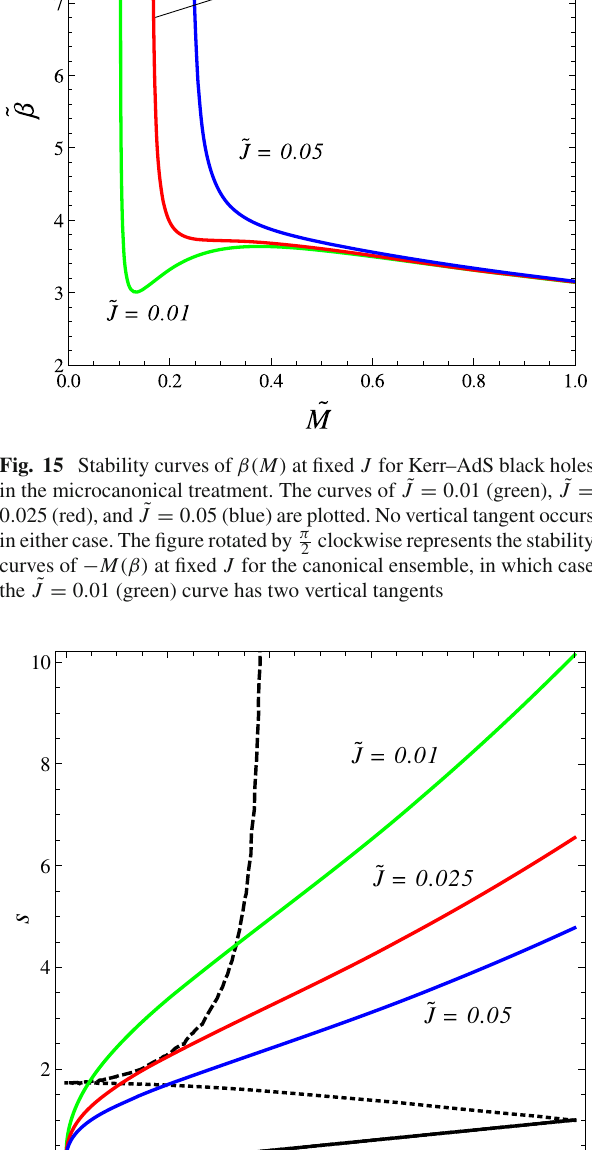
Fig. 16 Plots of J = const. curves for ˜ J = 0 . 01 (green), ˜ J = 0 . 025 (red) and ˜ J = 0 . 05 (blue) on the ( p , s ) space